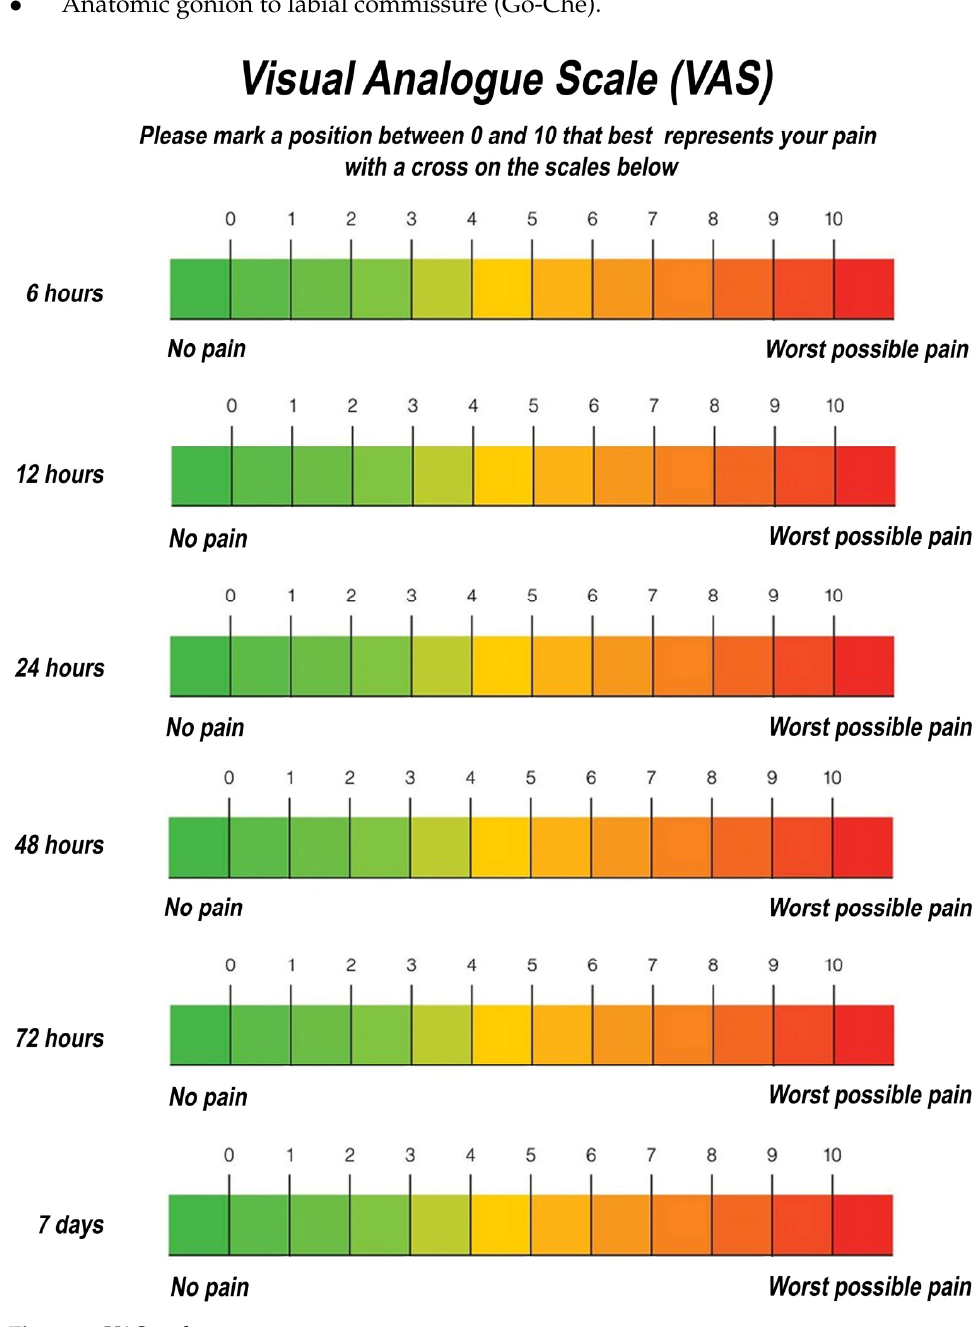
Figure 1. VAS Figure 1. VAS scale.